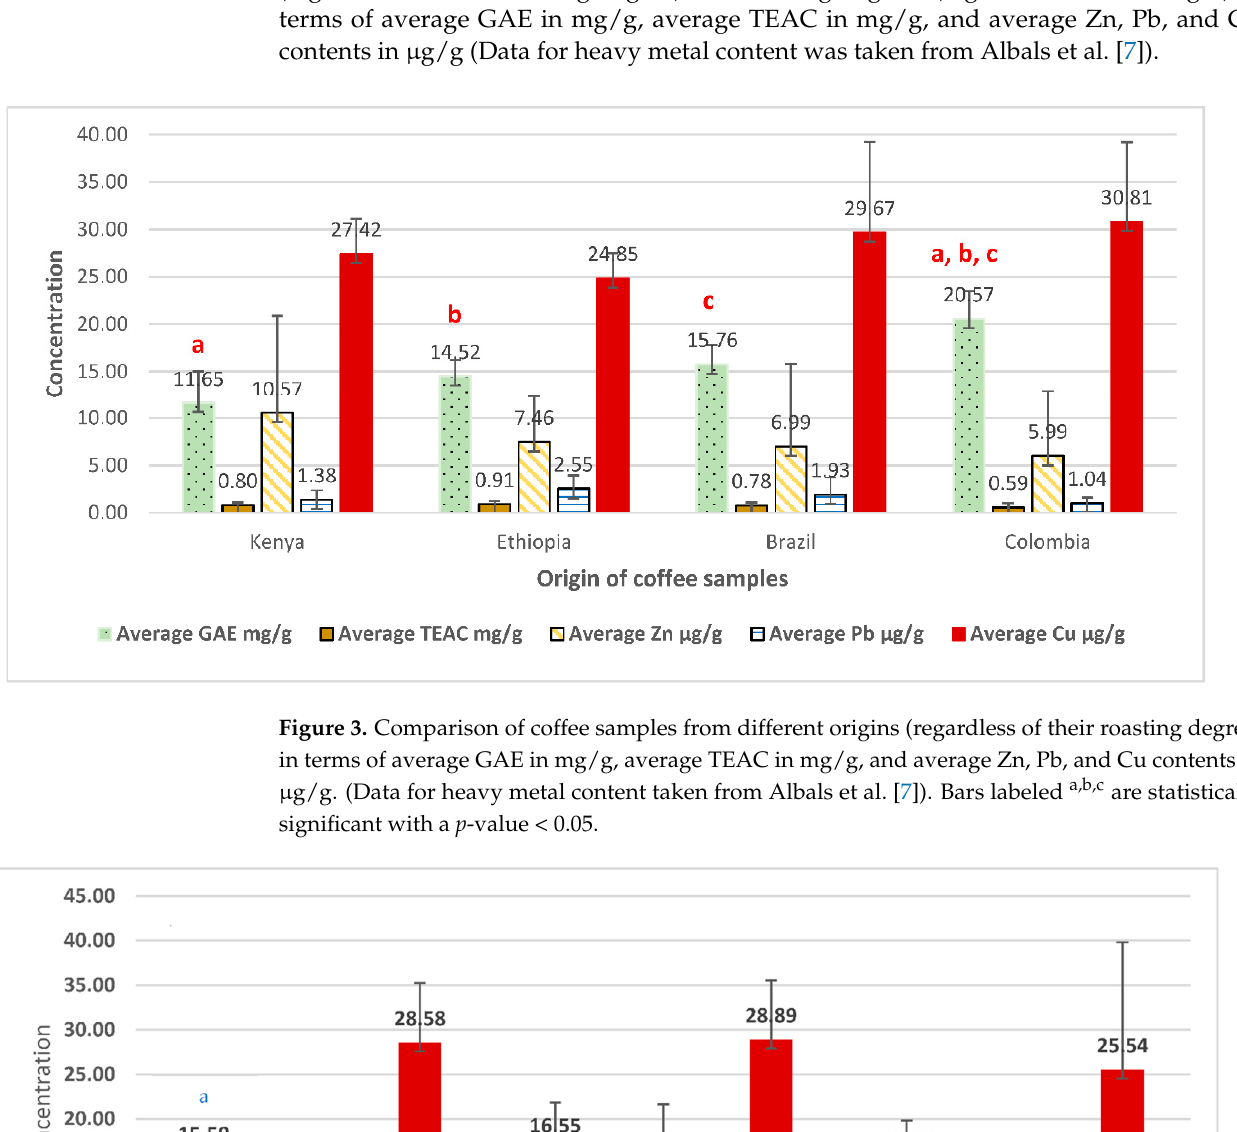
Figure 2. The average antioxidant activity (mg/g TEAC) for each roasting degree (different geographical origin) A negative correlation was found between roasting degree and TEAC mg/g (R 2 = 0.98). Bars labeled a,b are statistically significant with a p- value < 0.05.